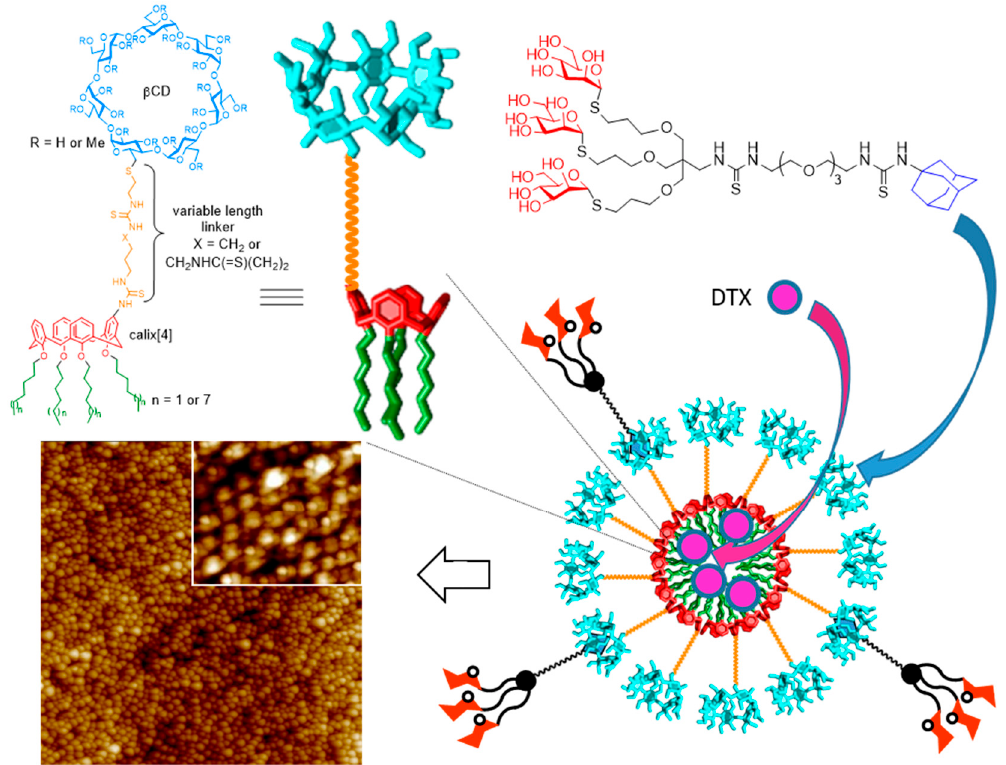
Figure 20. Illustration of the nanospheres (NSs) prepared by nanoprecipitation of β CD-calix[4]arene hybrids by Sansone, Casnati, García Fernández, Ceña and coworkers [185–187], their loading with anticancer drugs (e.g., docetaxel, DTX) and their host–guest decoration with glycoligands for targeted delivery. A representative tapping-mode atom force microscopy (AFM) image of the NSs (5 × 5 μ M; insert 0.7 × 0.7 μ M) is also shown. Adapted with permission from Reference [187]. Copyright Royal Society of Chemistry.